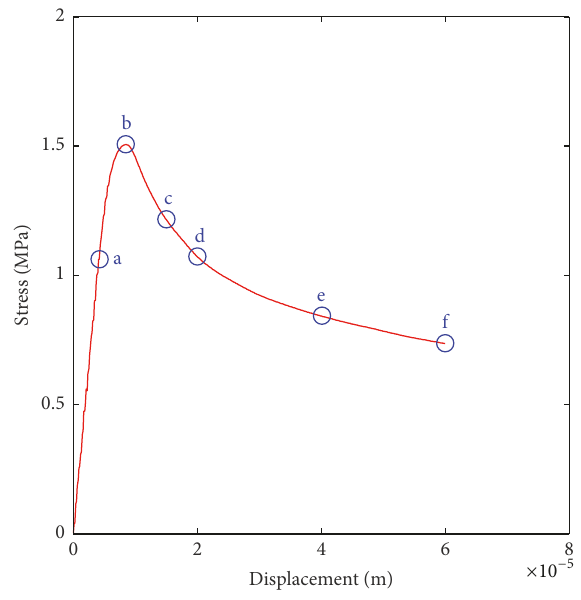
Figure 9: Stress-displacement curve ( 𝐴 𝐹 = 40 %, 𝐴 V = 2 %).